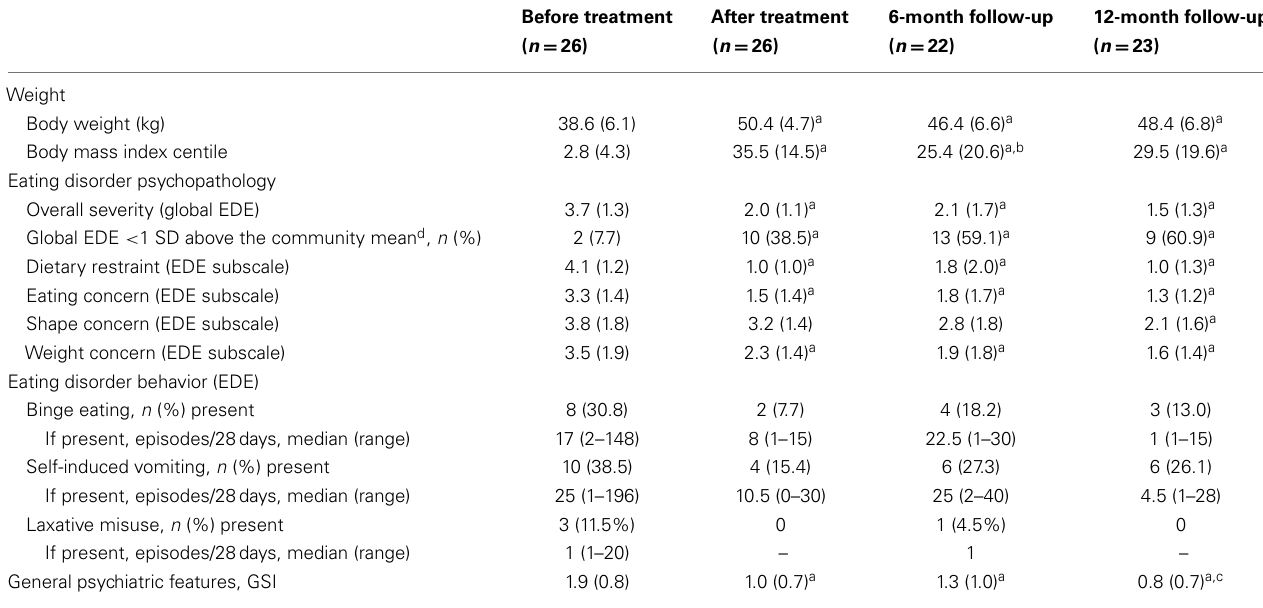
Table 2 | Characteristics of the patients before treatment, after treatment, and at 6- and 12-month follow-up among those who completed treatment